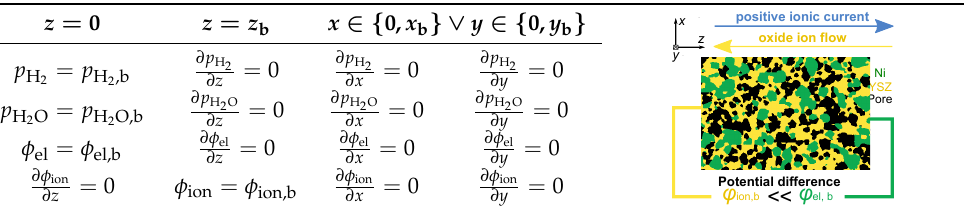
Table 1. Scheme of boundary